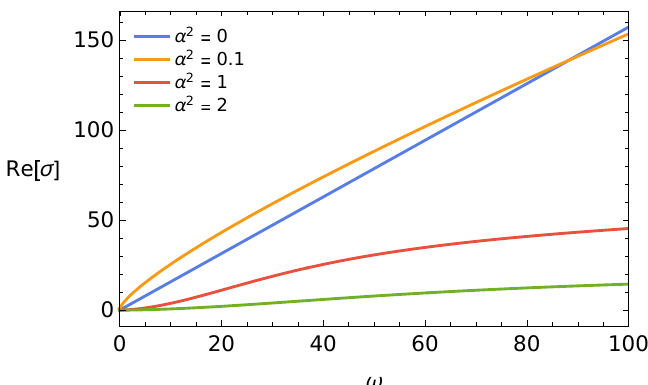
Figure 12. Conductivity for a Maxwell (cid:12)eld in AdS 5 without backreaction, but with a double- trace boundary deformation. The value of the coupling constant (cid:11) 2 determines the importance of the e(cid:11)ect of the double-trace deformation. The case (cid:11) 2 = 0 corresponds to the standard solution Re[ (cid:27) ( ! )] = !(cid:25)= 2.